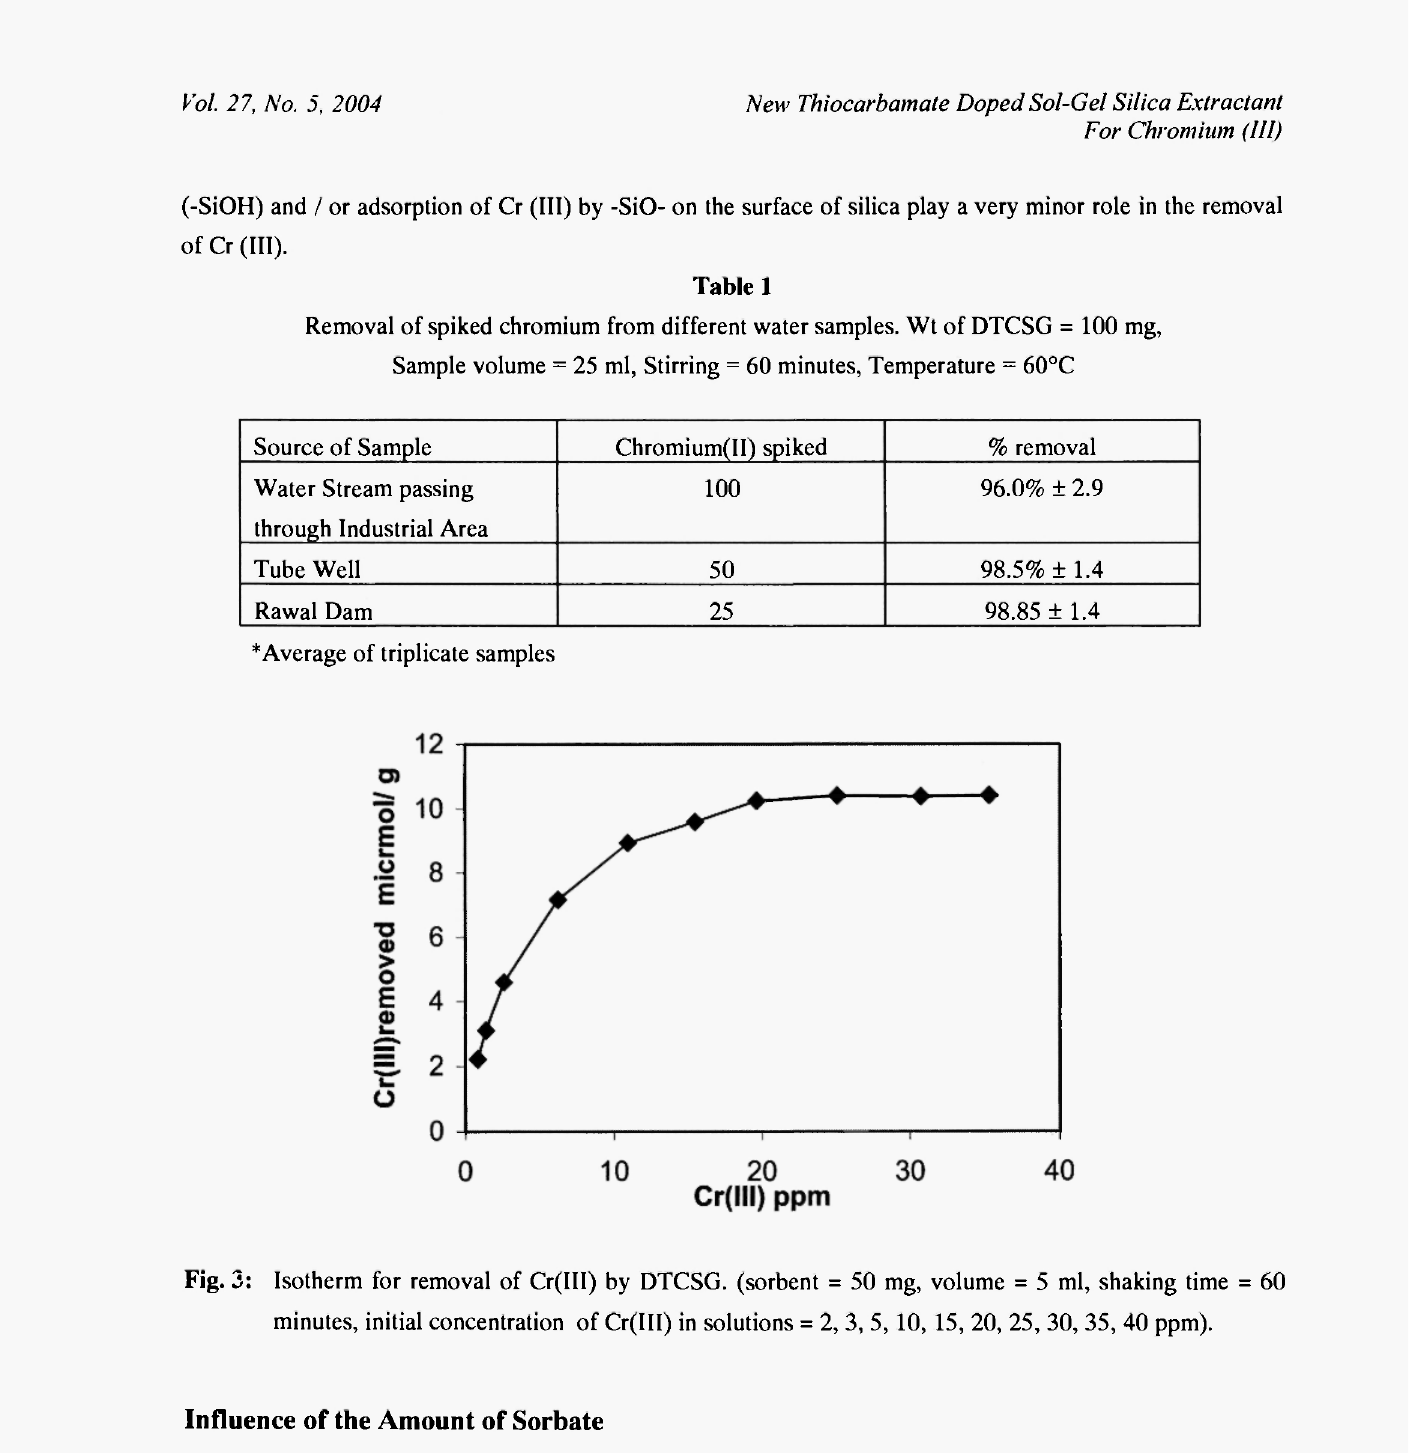
Influence of the Amount of Sorbate